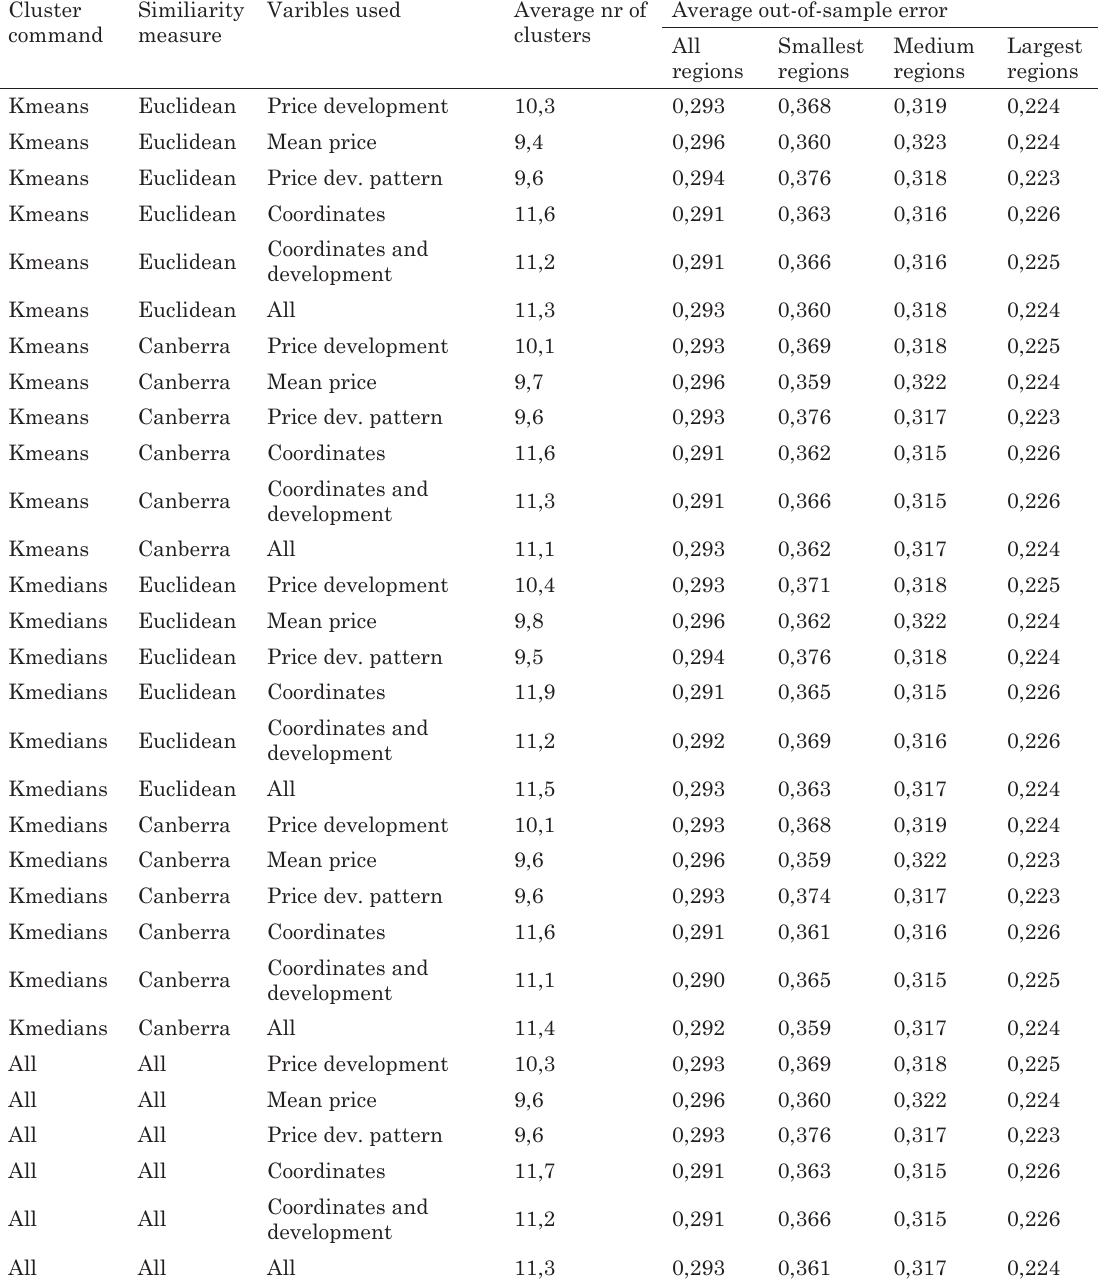
Table 8. Results from 100 replications of each clustering, in total 400